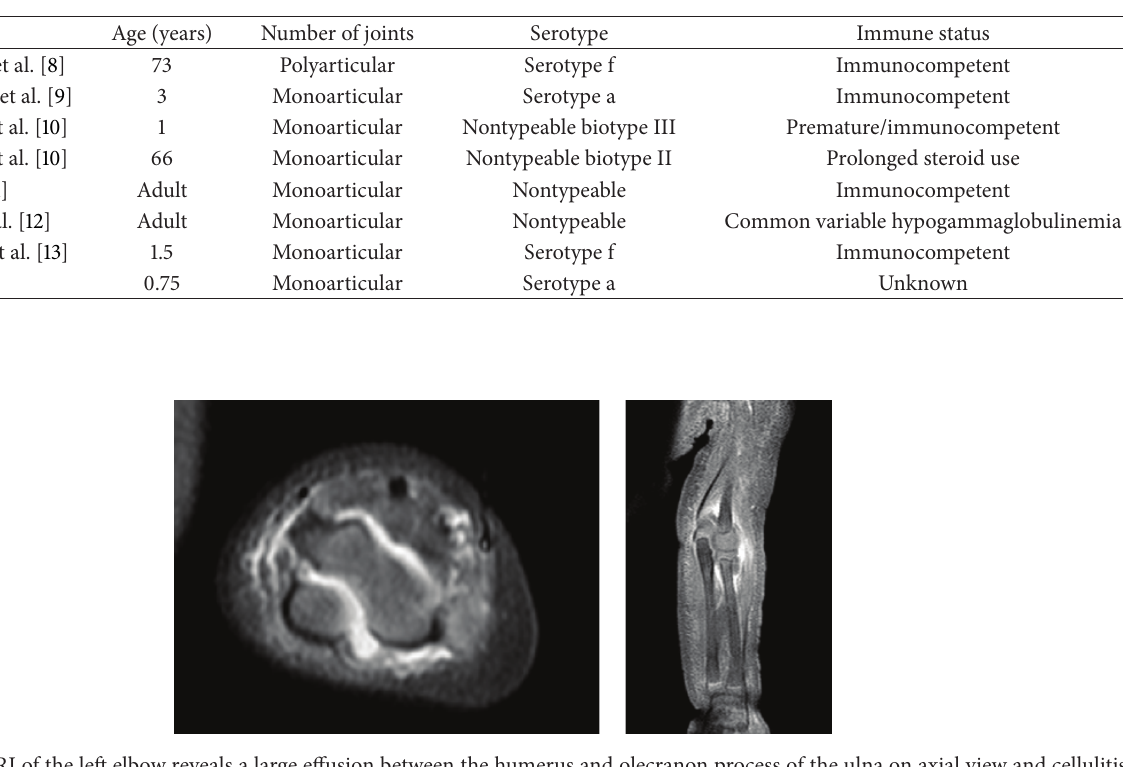
Figure 3: MRI of the left elbow reveals a large effusion between the humerus and olecranon process of the ulna on axial view and cellulitis and myositis on coronal view. Osteomyelitis was not